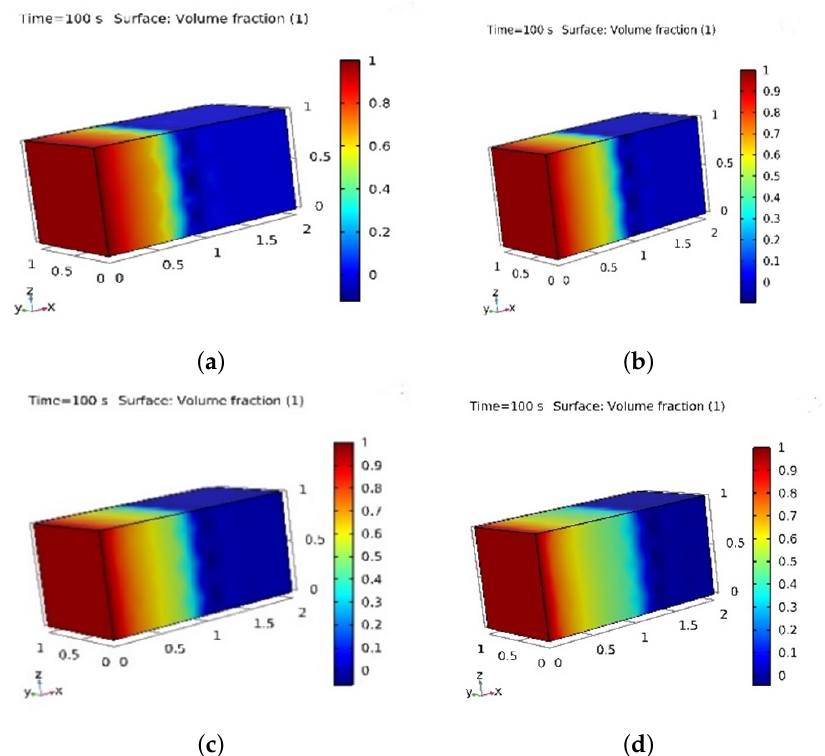
Figure 11. ( a ) Water saturation at 100 s with T in = 353.15 K, ( b ) copper at 100 s with T in = 353.15 K, ( c ) aluminum at 100 s with T in = 353.15 K, and ( d ) silicon oxide at 100 s with T in = 353.15